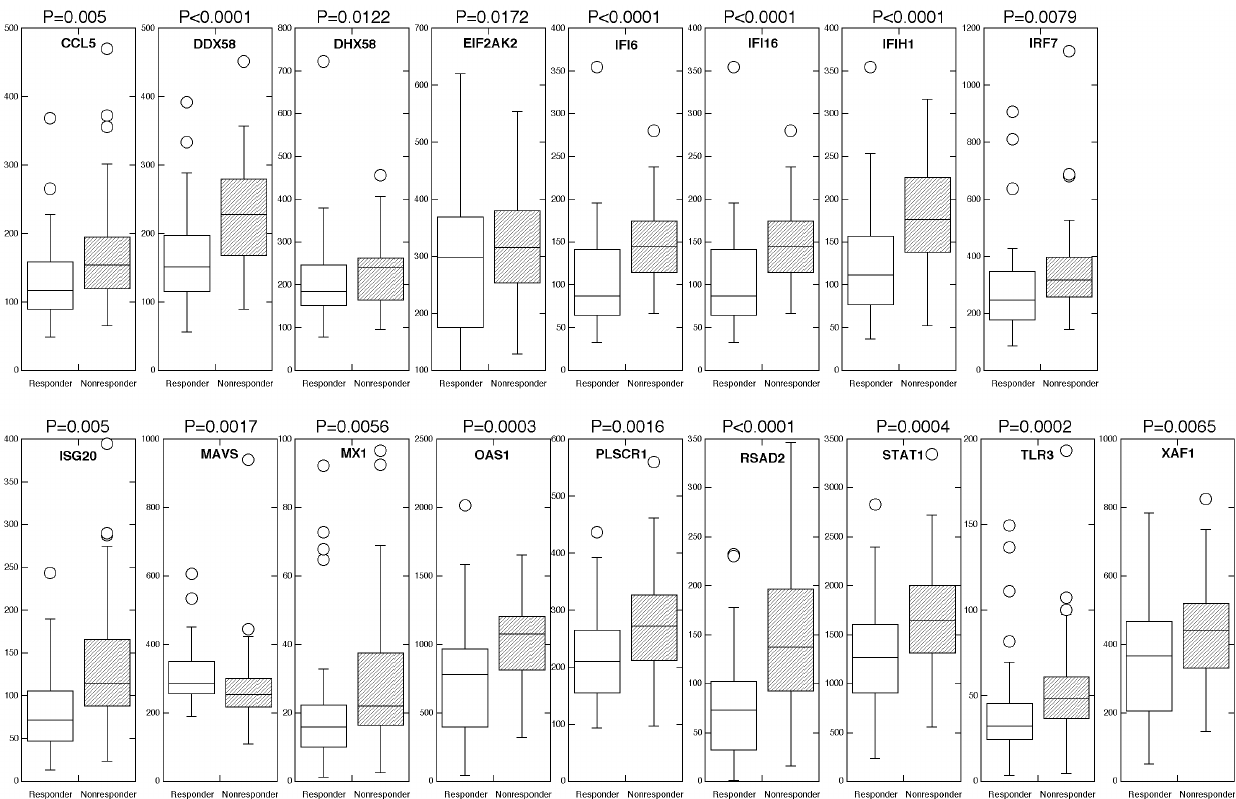
Figure 1. Differential expression of an IFN-regulated signature geneset in responders versus nonresponders to therapy. Expression of an IFN-regulated signature geneset was determined in RNA extracted from FFPE liver biopsies by nCounter analysis. Boxplots of genes found to be statistically differentially expressed by nonparametric Mann-Whitney analysis (p , 0.05).